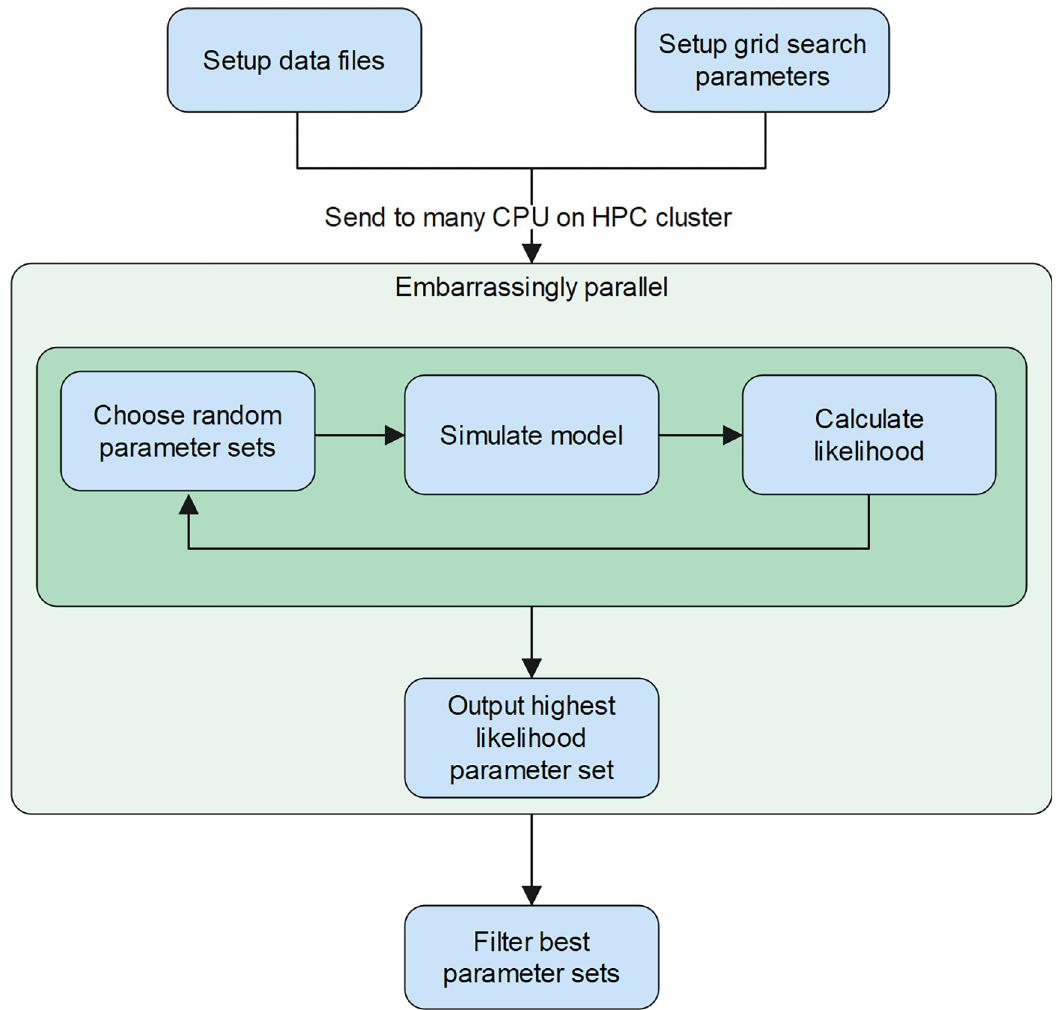
Fig 2. Implementation scheme of the grid search process on a high-performance computing cluster (HPC). On many CPUs simultaneously, we randomly search through the parameter space, and each CPU outputs a single best parameter set (based on likelihood calculations) that was discovered from its independent search